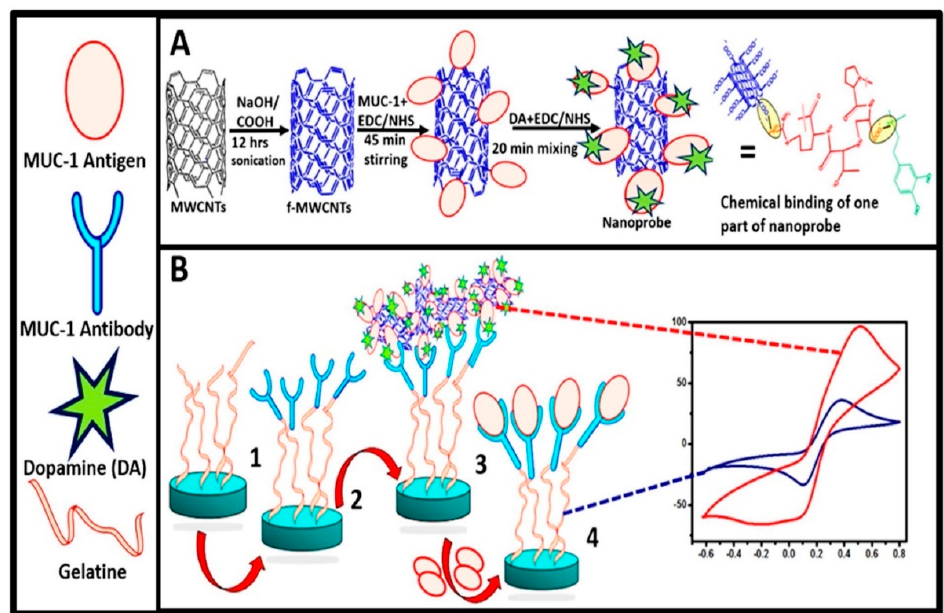
Figure 6. ( A ) Schematic illustration of the nanoprobe fabrication steps. ( B ) Working electrode modification along with immunosensor principle based on direct competitive electrochemical sensor for MUC − 1 detection. Several steps are involved: (1) Electro oxidative grafting of gelatin on electrode; (2) MUC − 1 antibody binding with EDC/NHS; (3) attaching nanoprobe with modified electrode; (4)